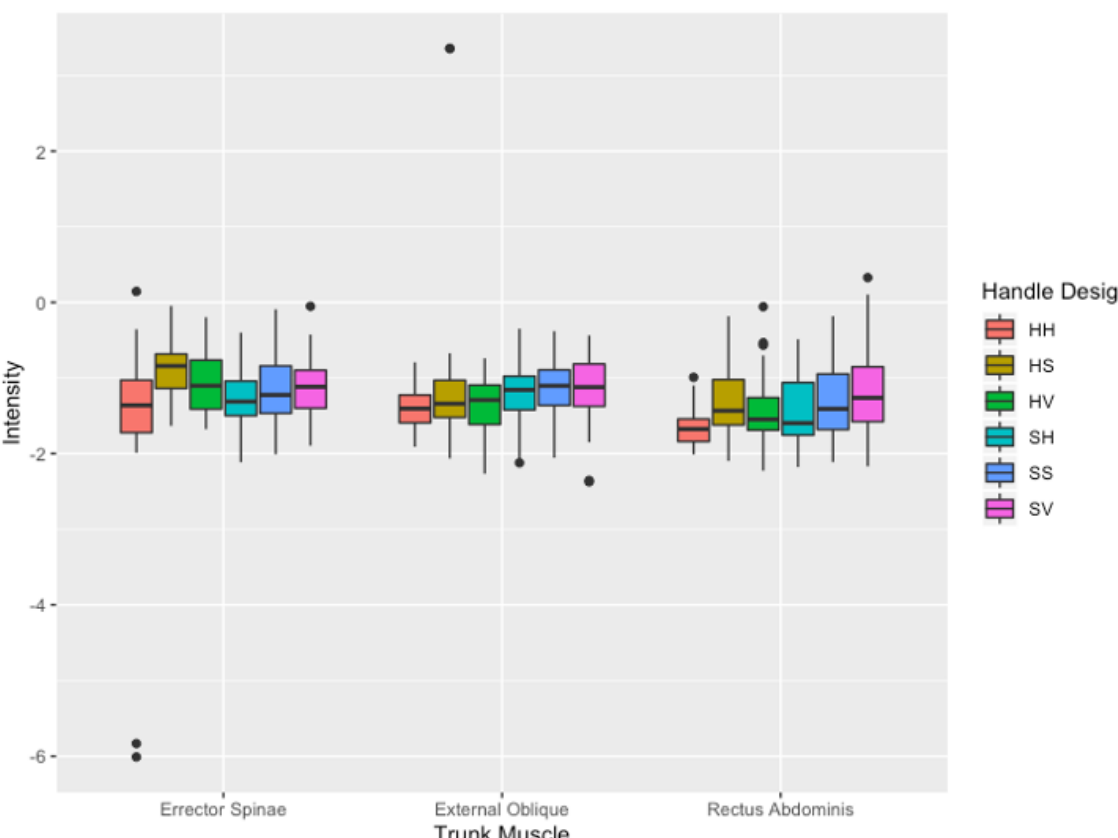
Figure 5. The heat intensity maps from the erector spinae of a female participant when initiating a push.